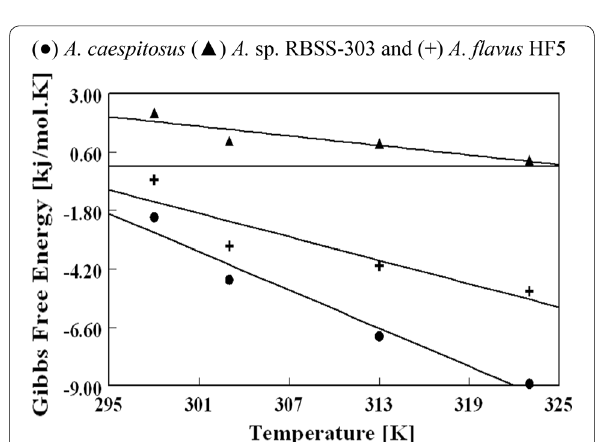
Fig. 7 Thermodynamic studies of Pb(II) biosorption by A. caespitosus , A. sp. RBSS-303 and A. flavus HF5 at different